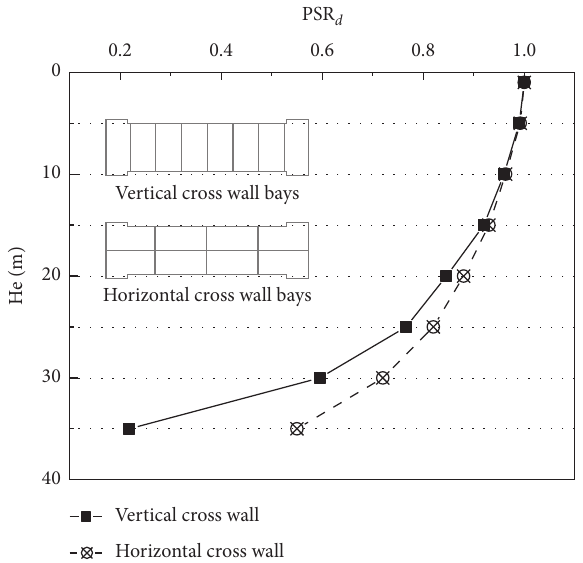
Figure 19: Relationship between PSR cross